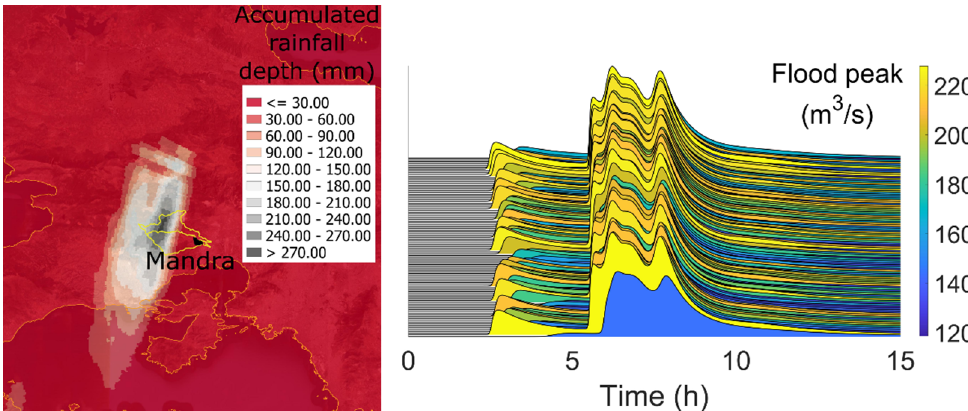
Figure 2. Accumulated rainfall depth recorded between 14 November 2017 at 22:30 and 15 November 2017 at 08:30 GMT (left); Joyplot of the 100 input hydrographs computed at Mandra town starting from 14 November 2017 at 22:30 until 15 November 2017 at 13:30 (right).